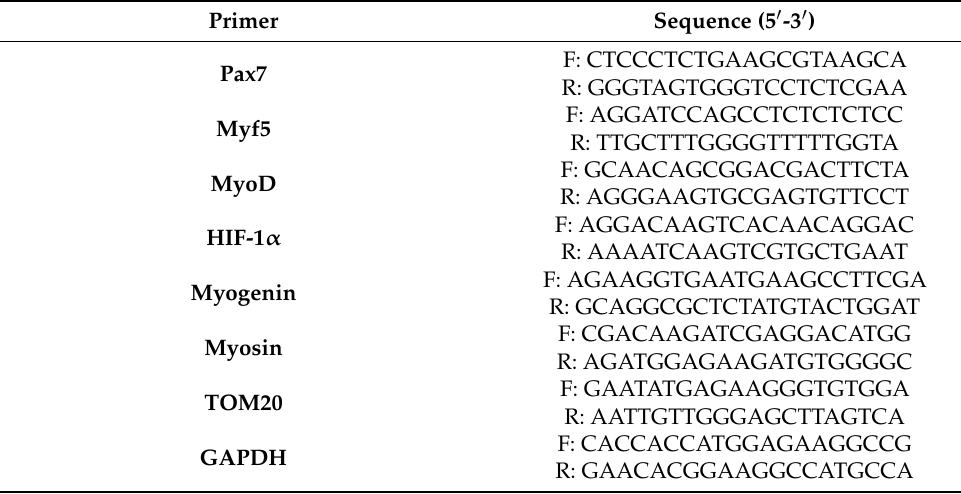
Table 1. Sequences of the primers used in the RT-qPCR study.